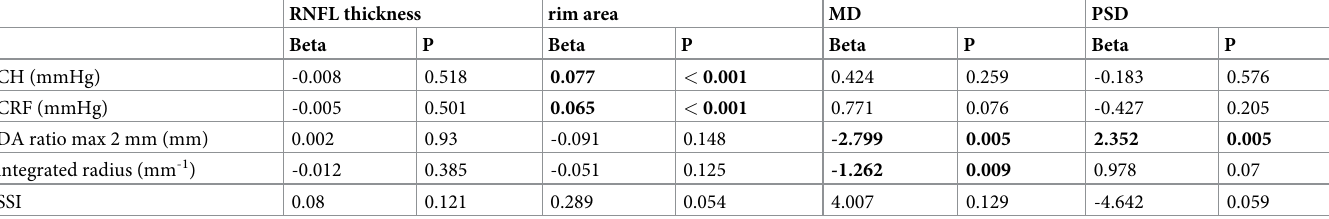
Table 4. Regression analysis of the association between corneal biomechanical parameters and functional (visual field) and structural (HRT) indices of glaucoma severity in normal pressure glaucoma (NPG) patients using generalized estimating